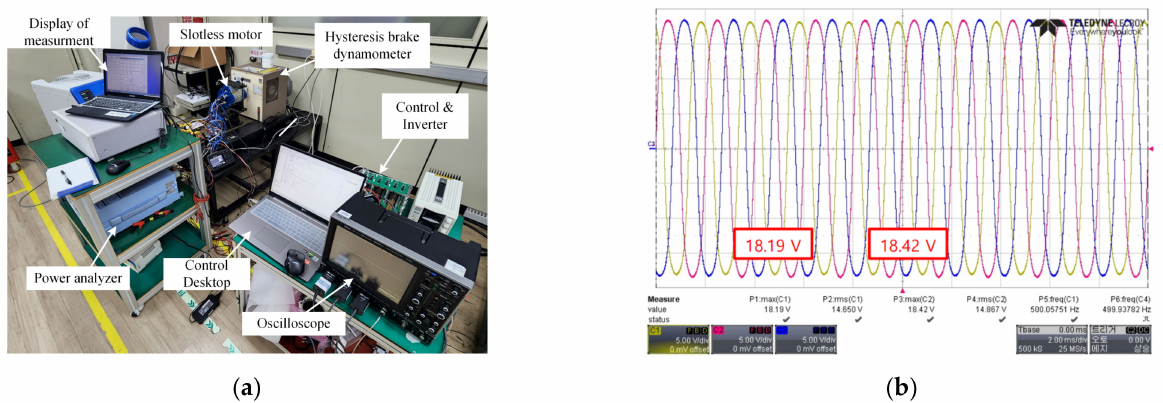
Figure 13. Experiment of the manufactured slotless motor: ( a ) experiment environment; ( b ) BEMF waveform @ 3000